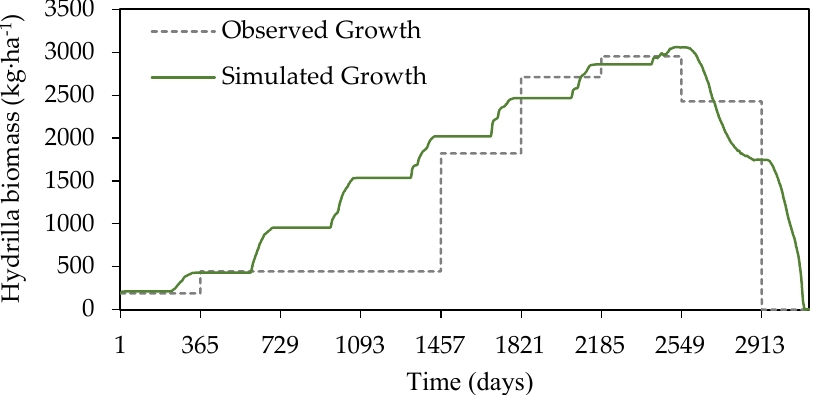
Figure 4. Comparison of biomass dynamics of Hydrilla simulated with the calibrated model to those observed in Lake Conroe from 1979 to 1983 [46].